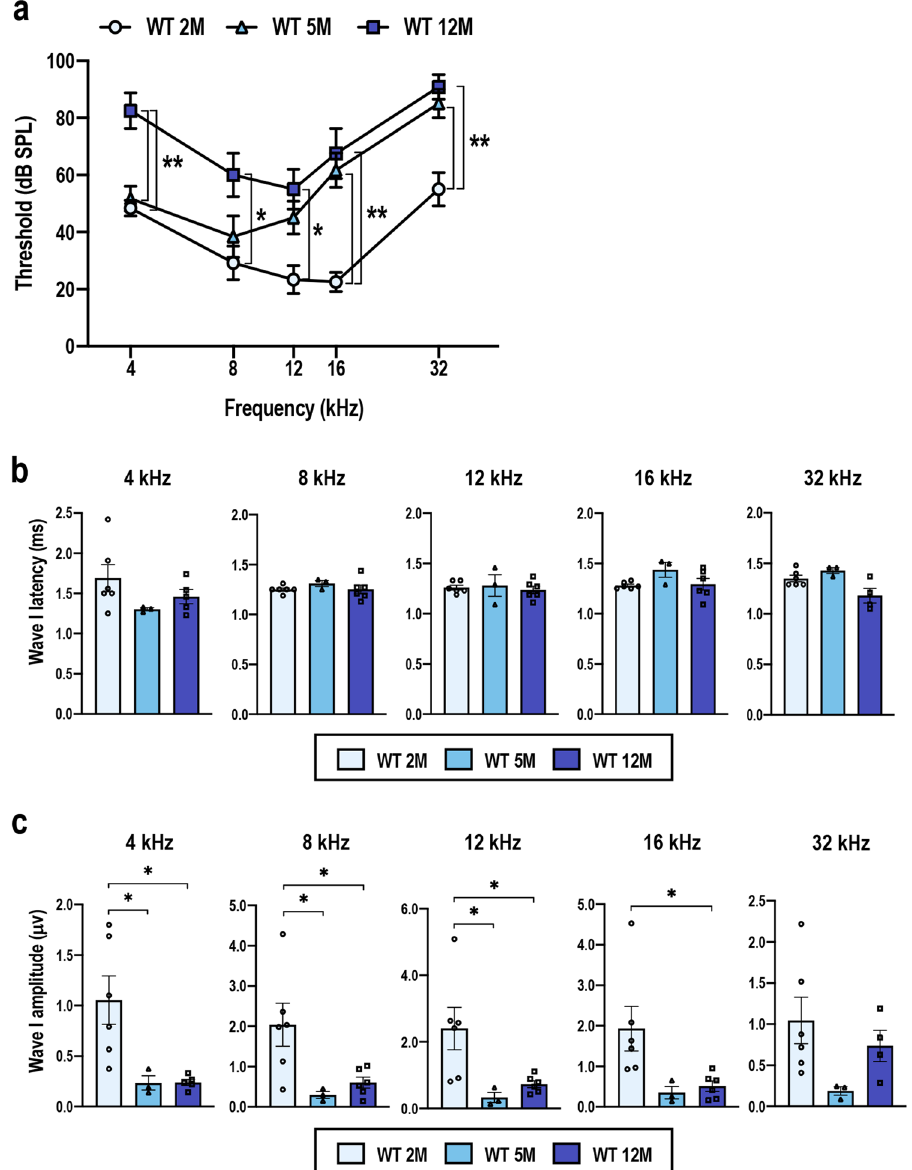
Fig. 1 Progression of hearing impairment in the WT C57BL/6 mice during aging. ABR thresholds ( a ), ABR wave I latencies ( b ), and ABR wave I amplitudes ( c ) of the wild-type (WT) C57BL/6 mice at the age of 2, 5, and 12 months ( n = 6 for 2-month-old mice, n = 3 for 5-month-old mice, and n = 6 for 12-month-old mice). The data represent the mean ± SEM. * P < 0.05, ** P < 0.01. Two-way analysis of variance (ANOVA) followed by Tukey ’ s multiple comparison test was applied. As the ABR wave I latencies and amplitudes that were induced by a stimulus intensity of 100 dB SPL were measured, one and two 12-month-old mice that exhibited ABR thresholds above 100 dB SPL at 4 and 32 kHz, respectively, were omitted from the waveform analysis shown in b and c